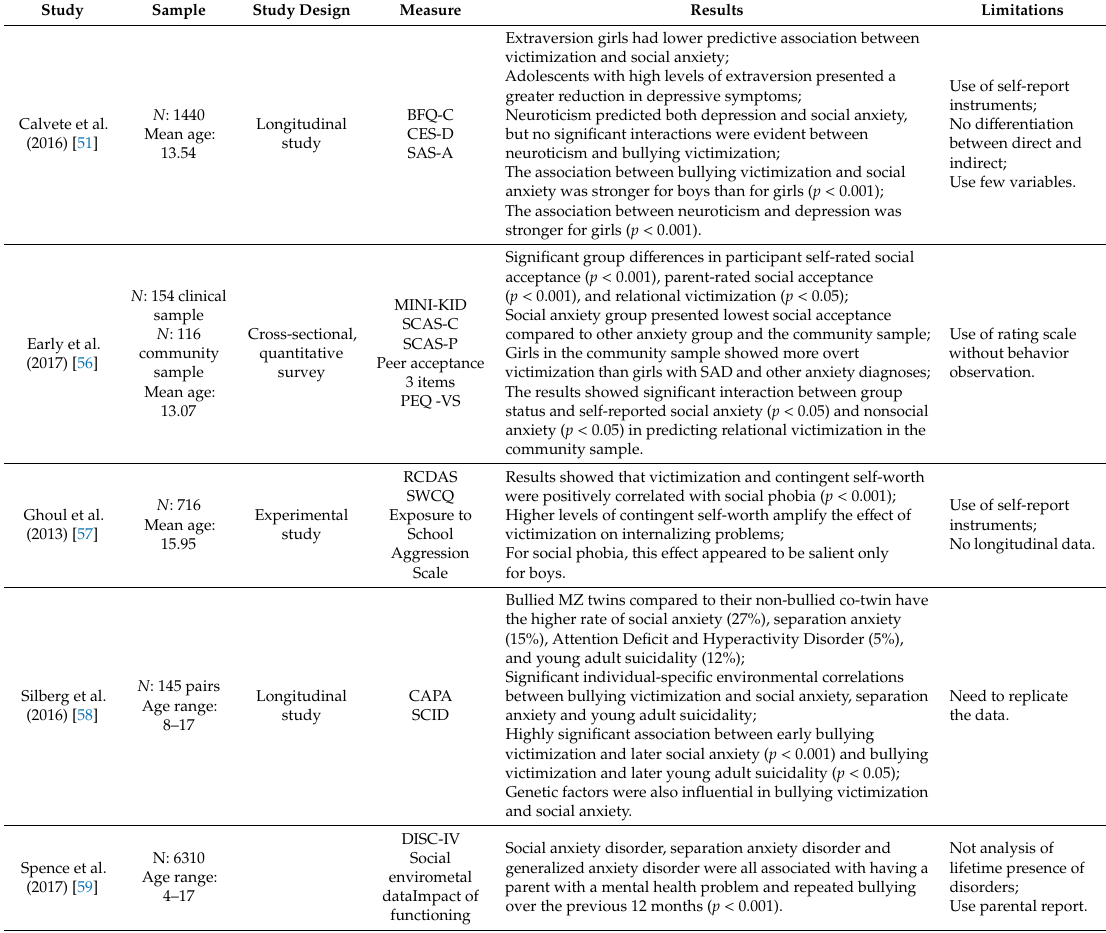
Table 2. Results of included studies. Extraversion girls had lower predictive association between victimization and social anxiety; Adolescents with high levels of extraversion presented a greater reduction in depressive symptoms; Neuroticism predicted both depression and social anxiety, but no significant interactions were evident between neuroticism and bullying victimization; SAS-A The association between bullying victimization and social anxiety was stronger for boys than for girls ( p < 0.001); The association between neuroticism and depression was stronger for girls ( p < 0.001).